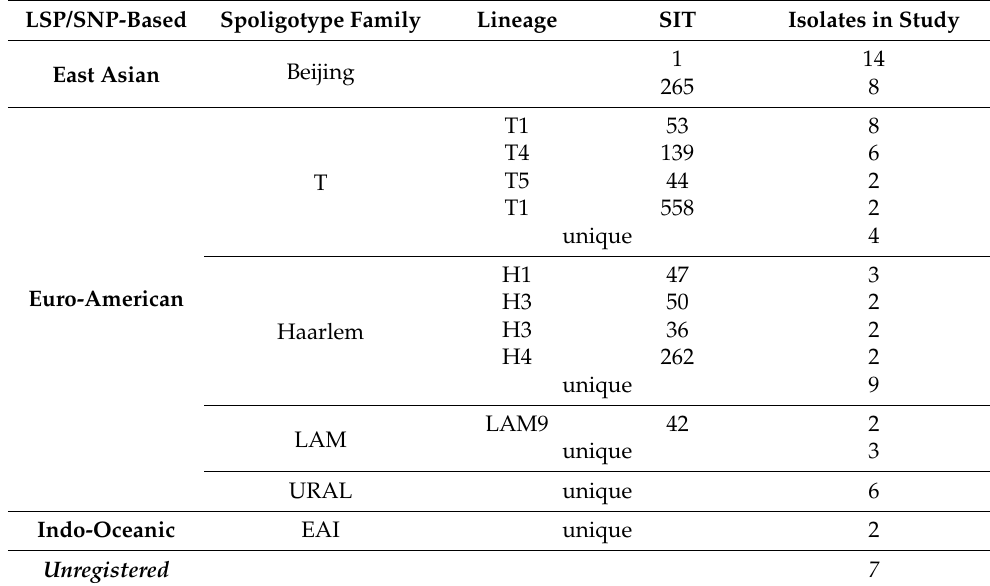
Table 5. Prevalence of the most common spoligotypes of resistant strains of Mycobacterium tuberculosis in Poland in 2020 (n =